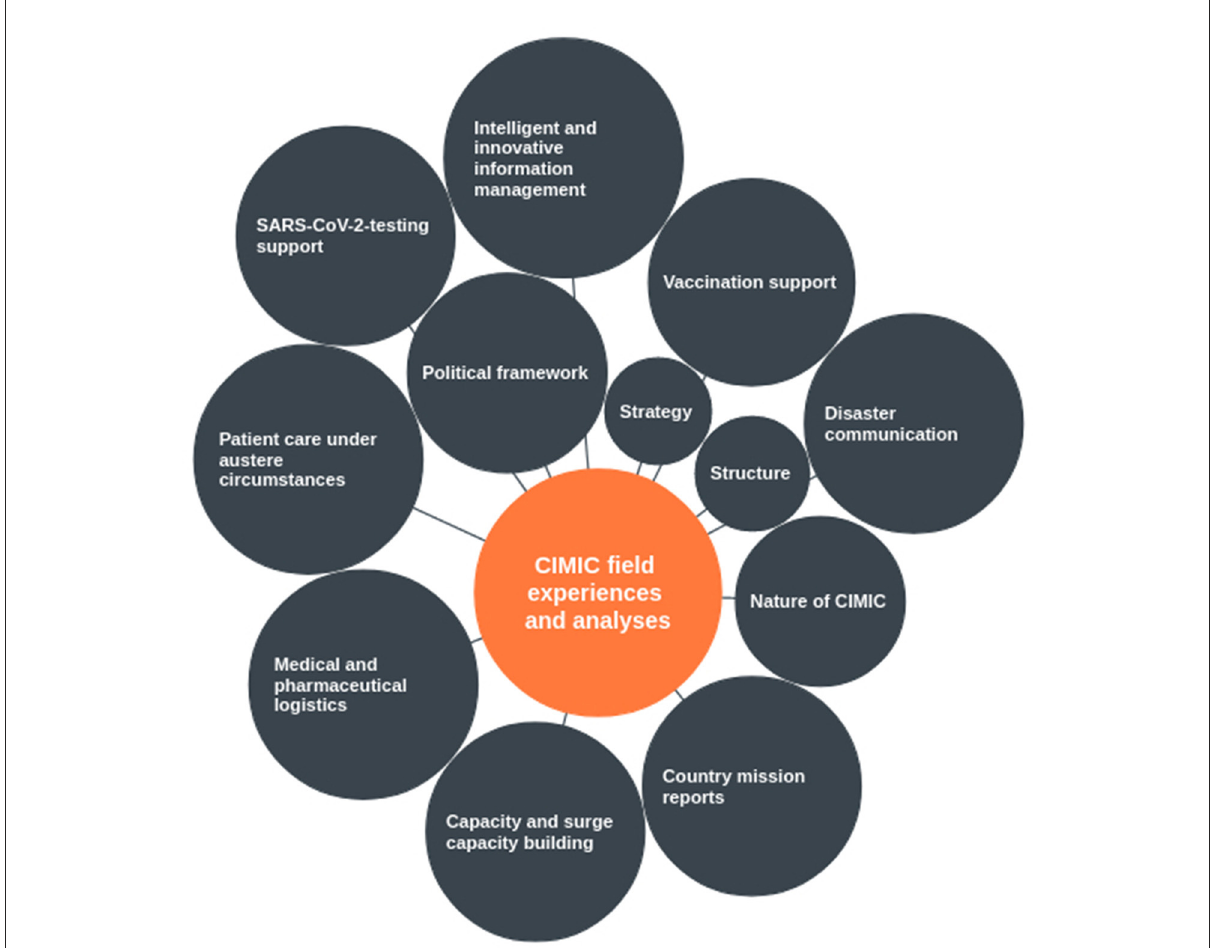
FIGURE5 Themes covered in CIMIC field experiences and analyses. Within individual reports, themes overlapped in